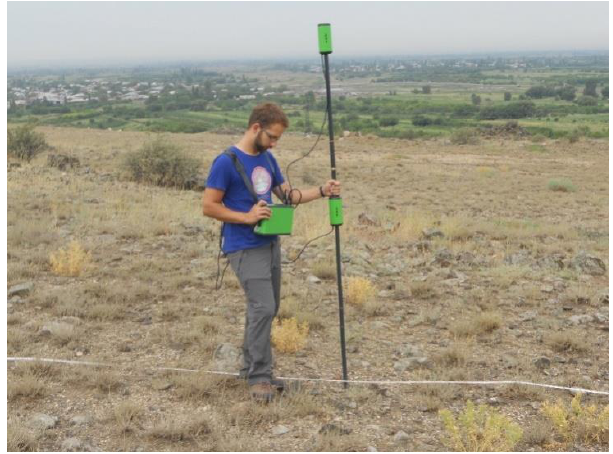
Figure 10. Armenia, Armavir province. PGM-1 gradient meter.